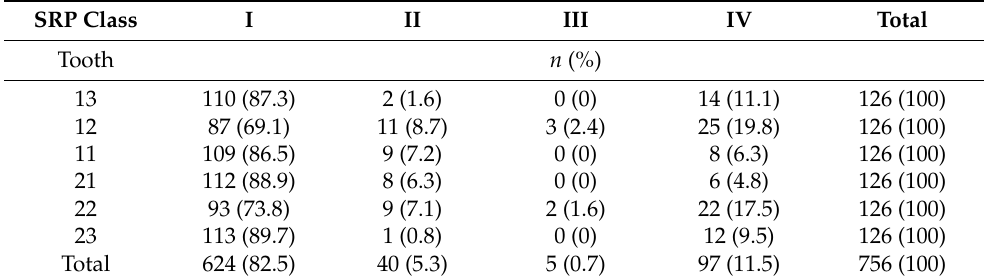
Table 2. Distribution of teeth according to SRP